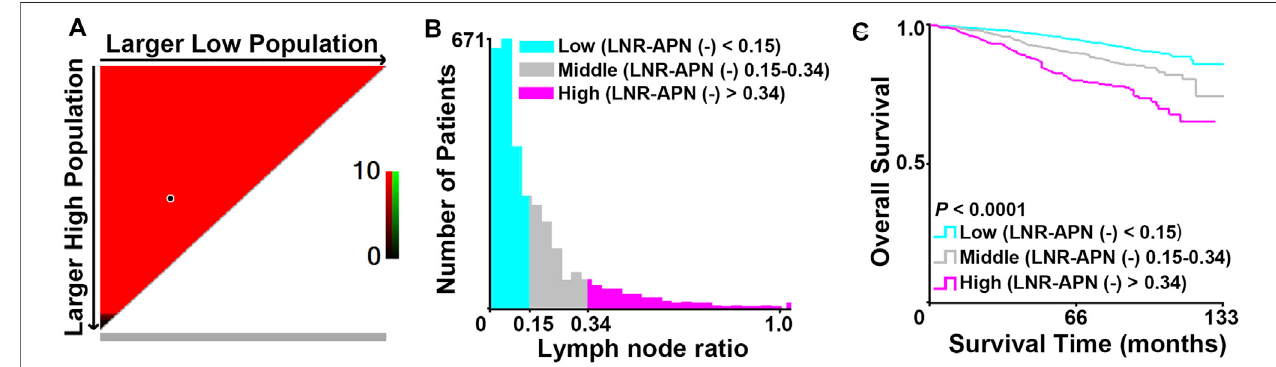
FIGURE3| Identi fi cationoftheoptimalcut-offvalues(0.15and0.34)forLNR-APN( − )byX-tileanalysisinAPN( − )patientswithpositivelymphnodesamong10,120 breast cancer patients. (A) Red indicates a negative association. X -axis demonstrates all potential cut-off values from low to high (left to right), de fi ned as larger low population. Y -axis demonstrates cut-off values from high to low (top to bottom), de fi ned as larger high population. (B) Histogram of the entire cohort divided into three